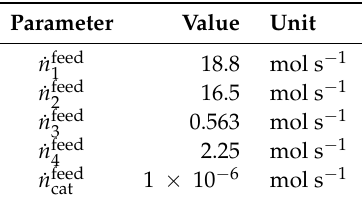
Table 4. Feed stream